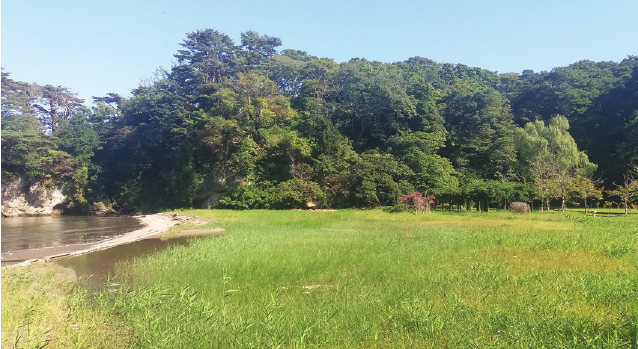
Fig 1. Grassland buffering the shoreline on Fukuura Island in Matsushima Bay, acting as a natural flood defense. Grasshoppers ( Oxya spp.) were numerous in this coastal corridor. Photo by